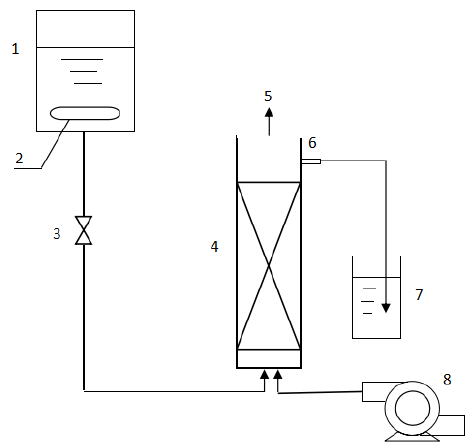
Figure 1. Schematic diagram of the packed-bed bioreactor. Note: 1. High slot. 2. Automatic constant temperature heating rod. 3. Valve. 4. Packed bed. 5. Air outlet. 6. Water outlet. 7. Low slot. 8. Air compressor.